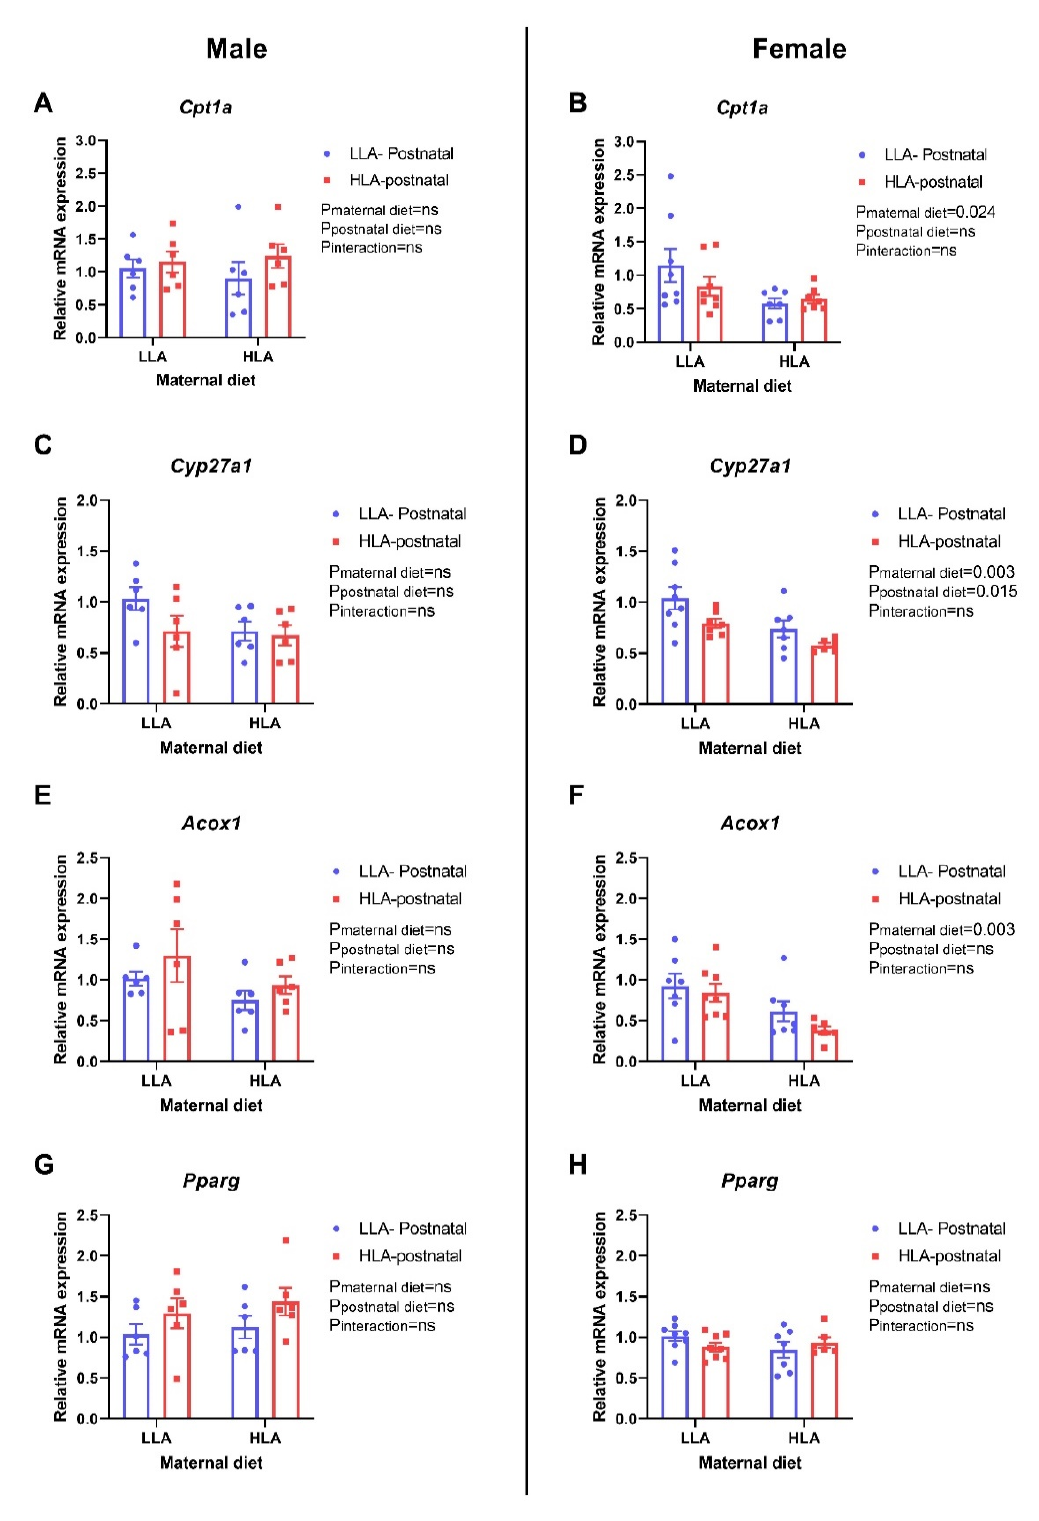
Figure 11. Effect of a maternal and postnatal diet high in linoleic acid on the expression of genes related to lipid metabolism in the liver of adult offspring. Data are presented as mean ± standard error of the mean (SEM). Two-way ANOVA was performed for statistical analysis with maternal diet and postnatal diet as two factors. n = 6–8. LLA: low linoleic acid; HLA: high linoleic acid; PN: postnatal. A : Cpt1a mRNA male; B : Cpt1a mRNA female; C : Cyp27a1 mRNA male; D : Cyp27a1 mRNA female; E : Acox1 mRNA male; F : Acox1 mRNA female; G : Pparg mRNA male; H : Pparg mRNA female.